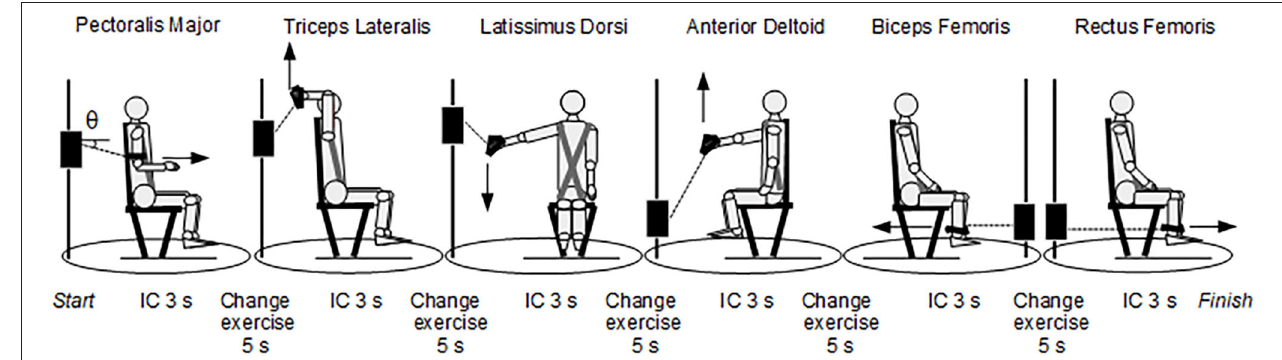
FIGURE 1 | Multi-stage isometric contraction test (MICT). In the left-most position, θ indicated the angle between the cable and the horizontal axis. The joint and cable angles in the six positions are: Pectoralis Major: shoulder flexed in neutral position (0 ◦ ) and elbow flexed by 90 ◦ , θ = − 15 ◦ ; Triceps Lateralis: shoulder flexed by 180 ◦ and elbow flexed by 90 ◦ , θ = + 55 ◦ ; Latissimus Dorsi: shoulder abducted by 75 ◦ , θ = − 45 ◦ ; Anterior Deltoid: shoulder flexed by 75 ◦ , θ = + 60 ◦ ; Biceps Femoris: knee flexed by 90 ◦ , θ = 0 ◦ ; Rectus Femoris: knee flexed by 90 ◦ , θ = 0 ◦ . IC = isometric contraction.